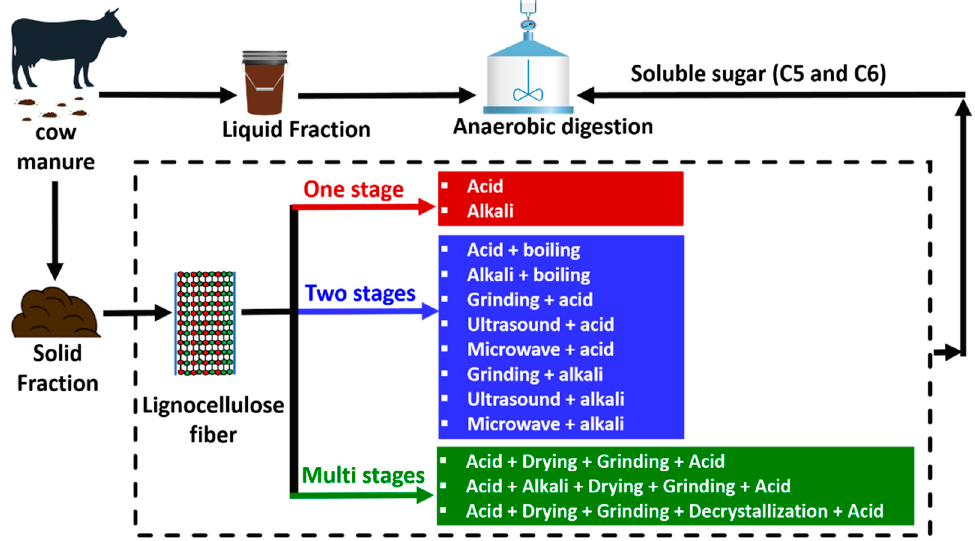
Figure 1. Chemical methods investigated for dairy manure hydrolysis.